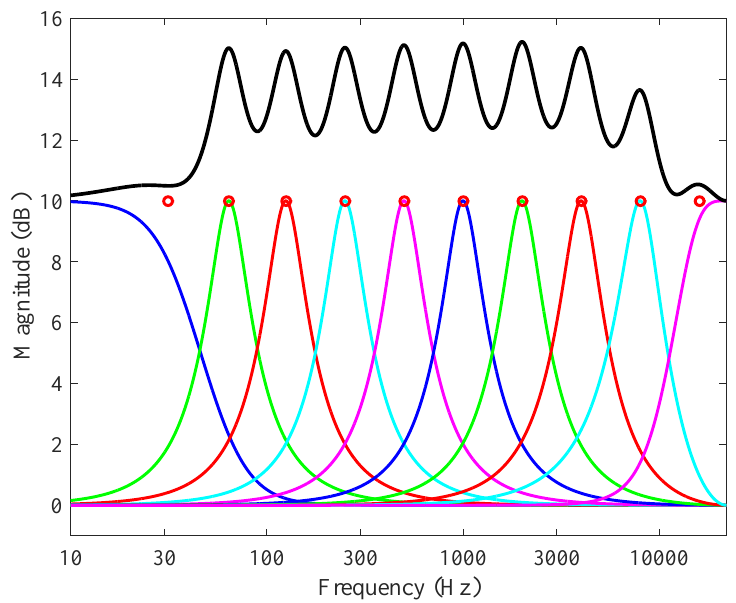
Figure 8. Magnitude responses of an octave graphic equalizer implemented using the cascade structure (thick line) and its two shelving and eight band filters with Q = 1.41 (colored curves). The red circles indicate the command gains, which are now all at